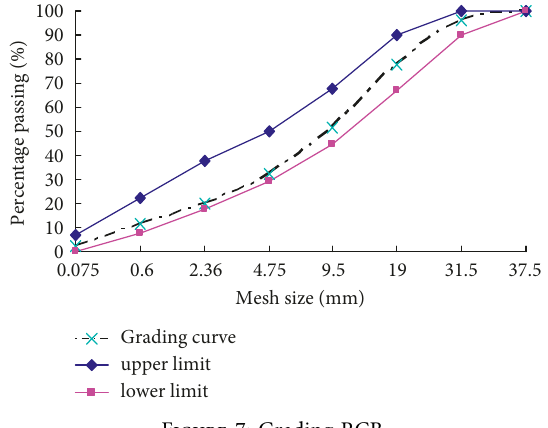
Figure 7: Grading RCB.